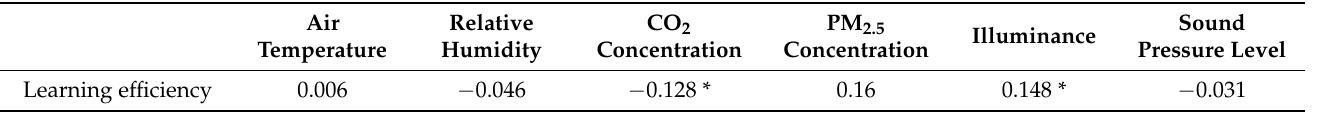
Table 9. Relationship between indoor environment and learning efficiency.